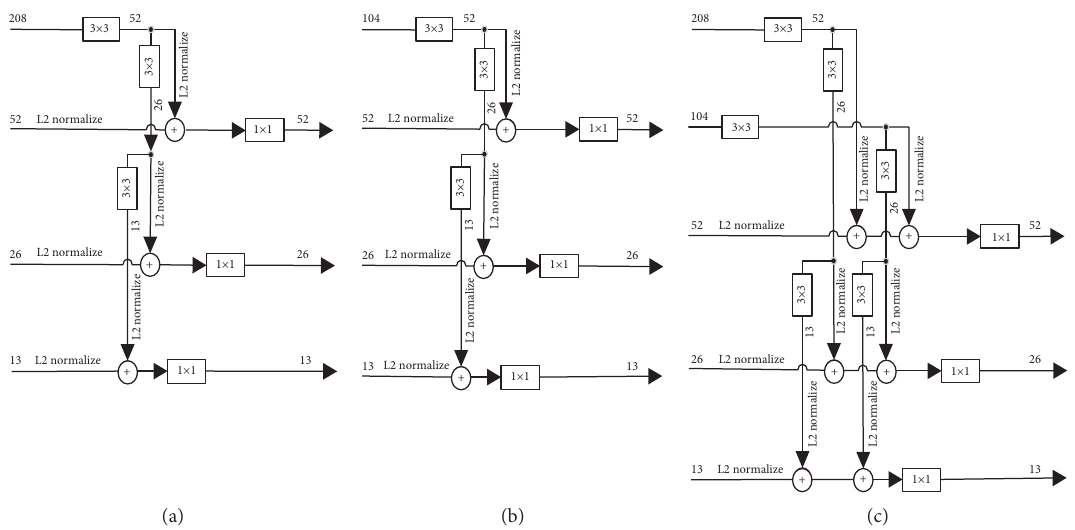
Figure 11: Multiscale feature fusion methods. (a) Fusion F1 layer. (b) Fusion F2 layer. (c) Fusion F1 and F2 layers. Table 5: mAP of MFF-Yolov4 on WT-DET: use L2 normalization. The connected layer comes from: